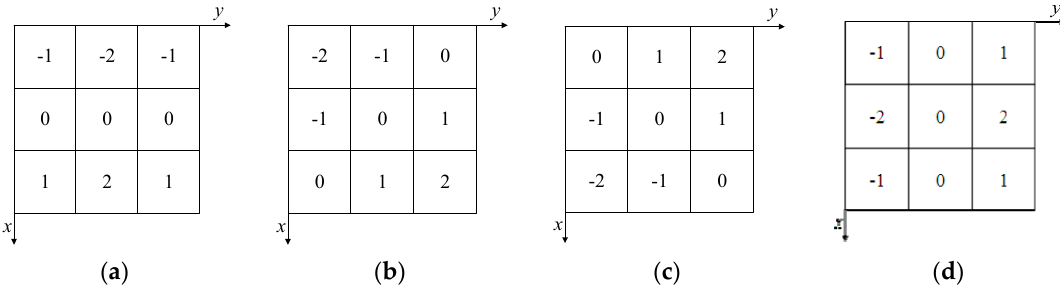
Figure 6. Sub ‐ masks for the sobel operator in four directions. ( a ) 0°; ( b ) 45°; ( c ) 90°; ( d ) 135°. Figure 6. Sub-masks for the sobel operator in four directions. ( a ) 0 ◦ ; ( b ) 45 ◦ ; ( c ) 90 ◦ ; ( d ) 135 ◦